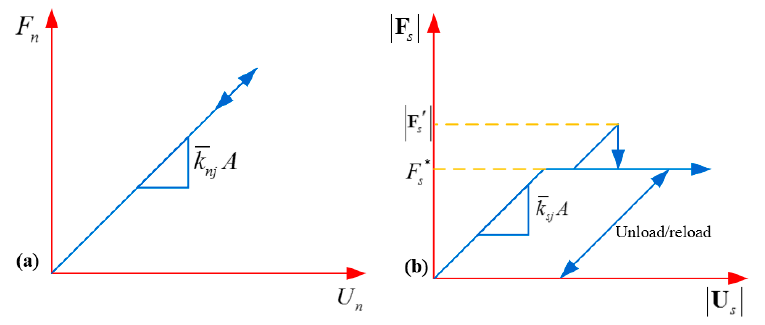
Figure 4. Smooth joint force-displacement law ( a ) normal force versus normal displacement; ( b ) shear force versus shear displacement.